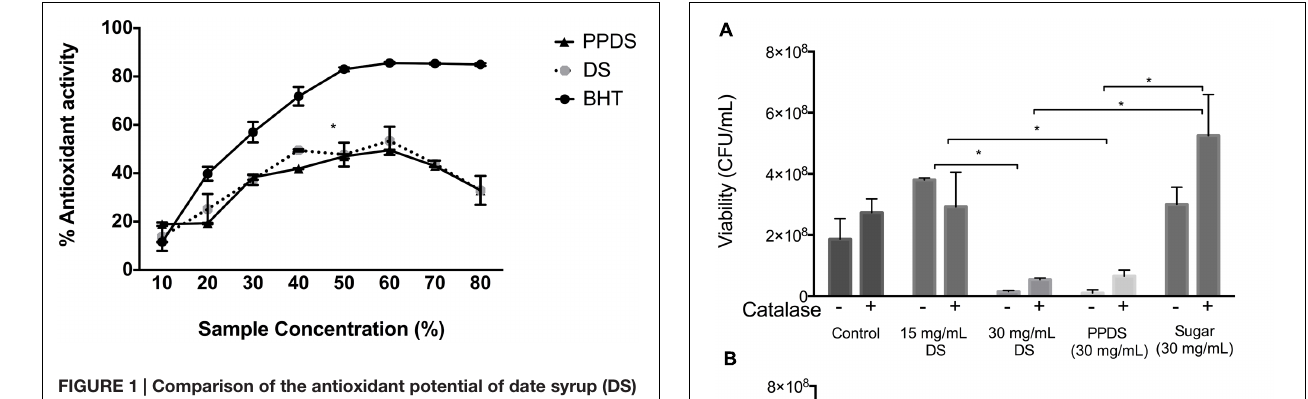
TABLE 2 | Minimum inhibitory concentration (MIC) and Minimum bactericidal concentration (MBC) of DS, and extracted DS polyphenols necessary to inhibit microbial growth in vitro expressed in mg/mL.